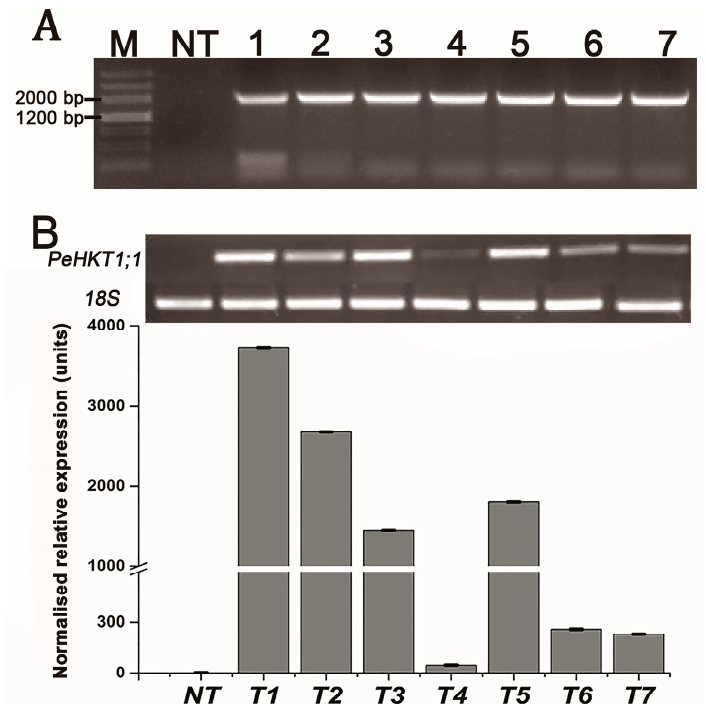
Figure 4. RT-PCR and qRT-PCR analyses of transgenic poplar lines. ( A ) Amplification of the inserted Figure 4. RT ‑ PCR and qRT ‑ PCR analyses of transgenic poplar lines. ( A ) Amplification of the inserted fragment from PeHKT1;1 and partial vector sequences by RT-PCR. ( B ) The expression level of PeHKT1;1 fragment from PeHKT1;1 and partial vector sequences by RT ‑ PCR. ( B ) The expression level of in the seven transgenic lines and NT poplar by SqRT-PCR and qRT-PCR. M: molecular marker; NT: PeHKT1;1 in the seven transgenic lines and NT poplar by SqRT ‑ PCR and qRT ‑ PCR. M: molecular non-transgenic poplar; 1–7: transgenic poplar marker; NT: non ‑ transgenic poplar; 1–7: transgenic poplar lines.